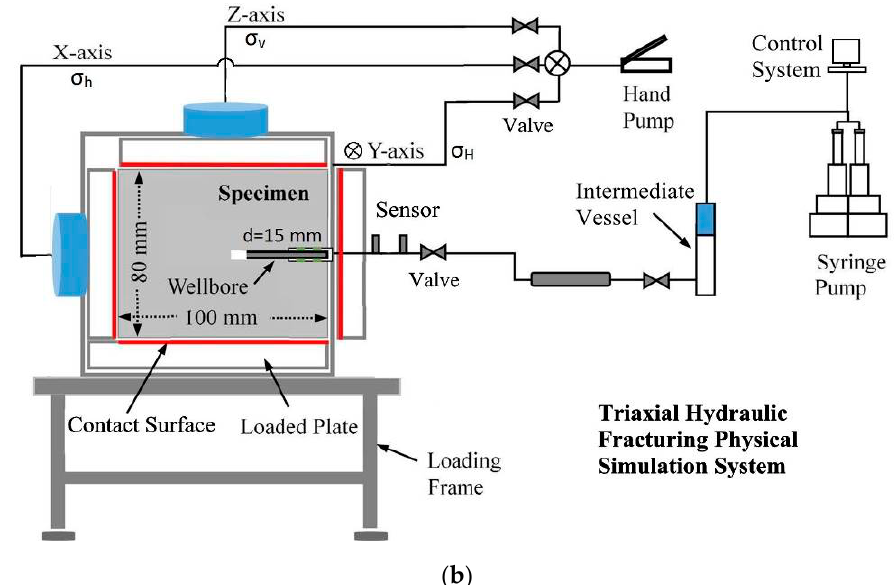
Figure 2. ( a ) Triaxial hydraulic fracturing physical simulation system setup; ( b ) experimental sketch [30,46].